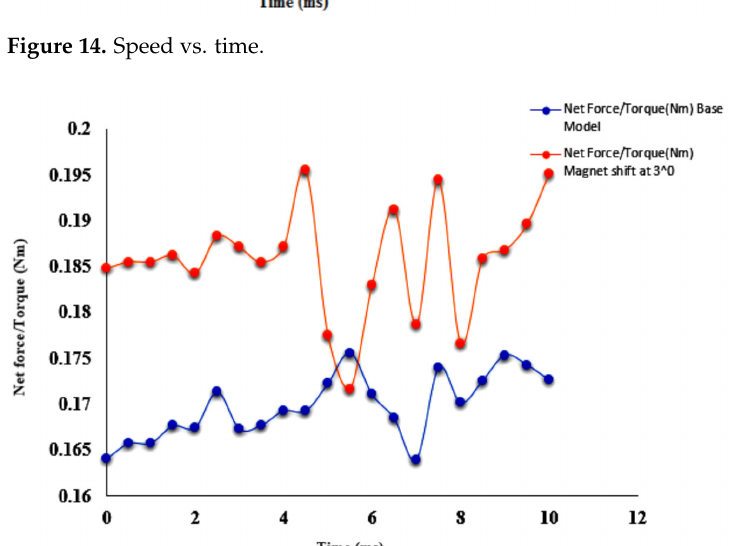
Figure 15. Magnetic force/torque vs.